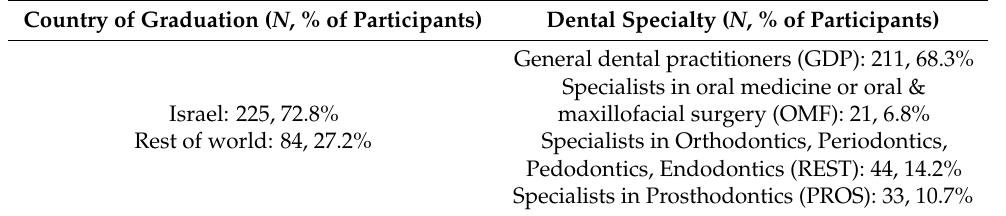
Table 2. Basic demographics of combined data ( n =